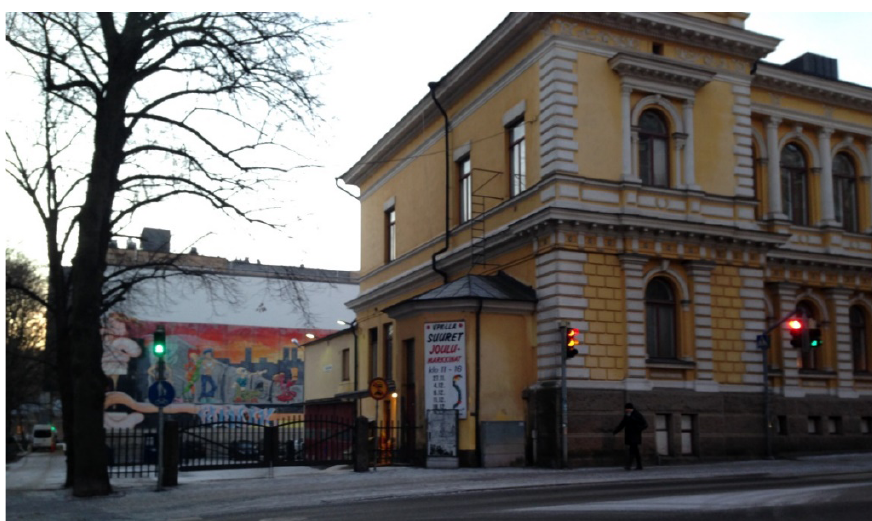
Figure 5. The old building (the VFB House) and iron gate against a contemporary